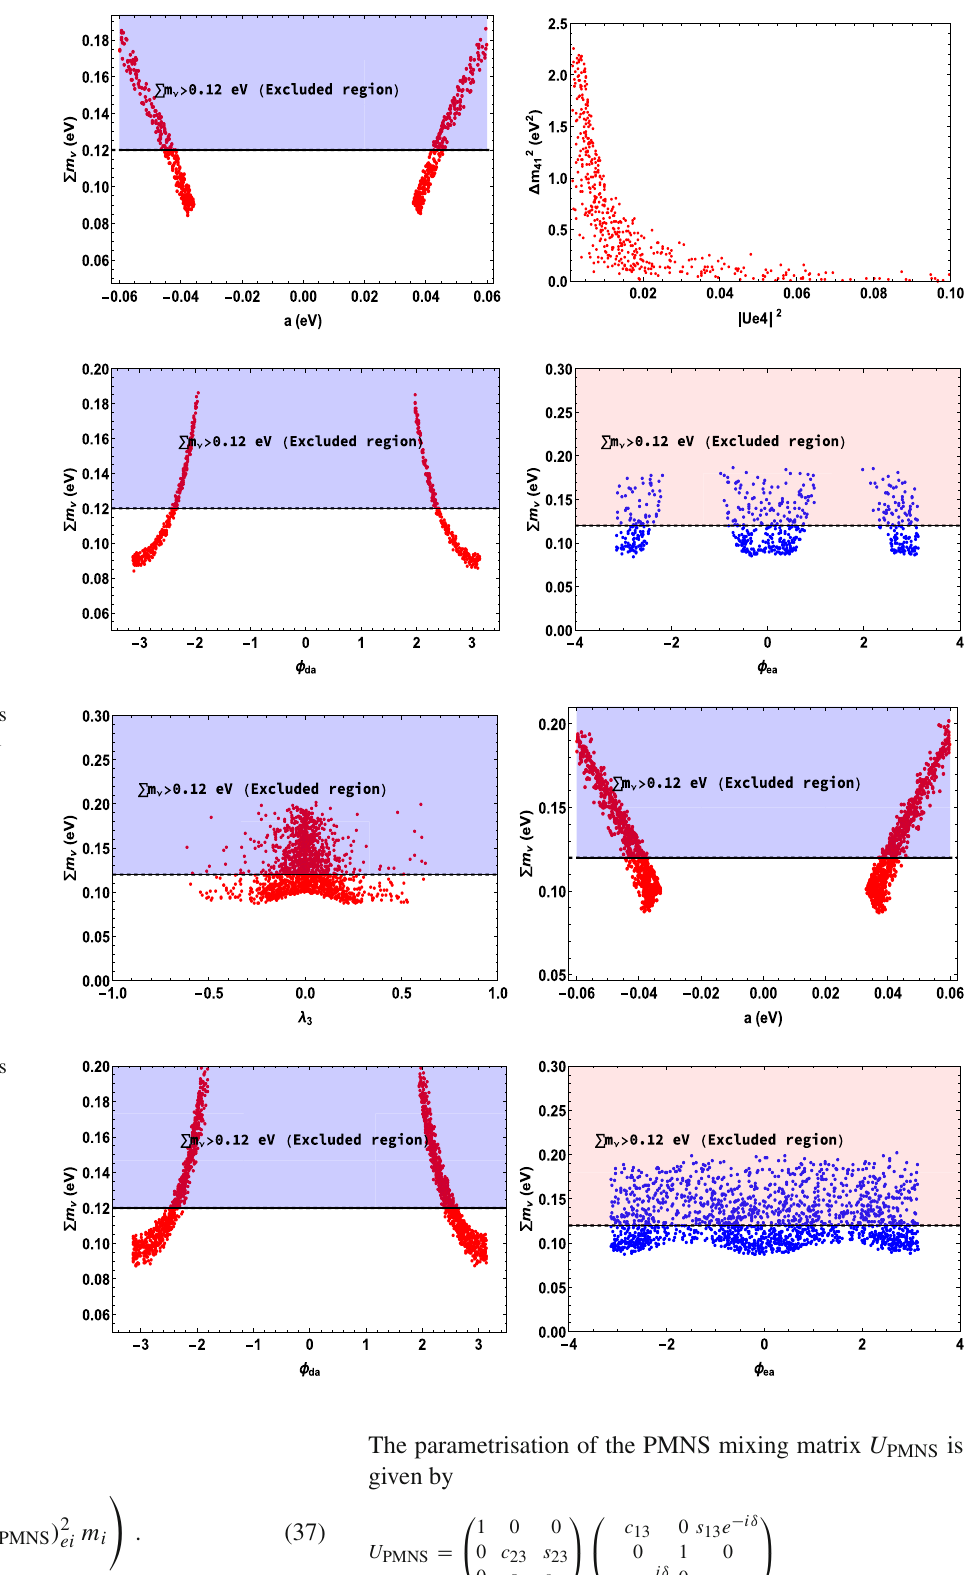
Fig. 4 Left panel projects the variation of model parameter a with total active neutrino mass and right panel represents the variation of φ 2 with total active neutrino mass